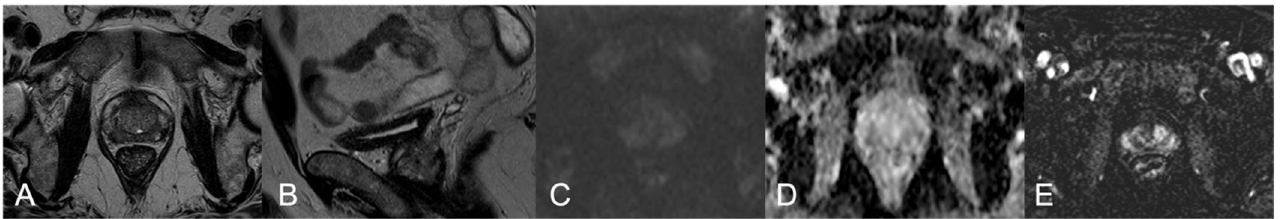
Figure 2. Non-specific GP in a 70-year-old patient (case 3). The mpMRI shows diffuse and inhomogeneous hypointensity on T2w axial ( A ) and sagittal ( B ) images with loss of peripheral/transition zone differentiation, markedly restricted diffusivity at high b-value ( C ) and corresponding marked low ADC value ( D ), inhomogeneous hyperenhancement at DCE ( E ). PIRADS v2.1 score 4 PZ diffuse. At transrectal US ( F ), preliminar to the fhTFTB, we can see multiple confluent hypoechoic areas both in the peripheral and transition zone. The free-hand transperineal fusion MRI/US-targeted biopsy ( G , g ): on the US image in ( G ) we can appreciate the needle entering into the target in red, in ( g ) we have the corresponding MRI-guidance image with the same target in red.